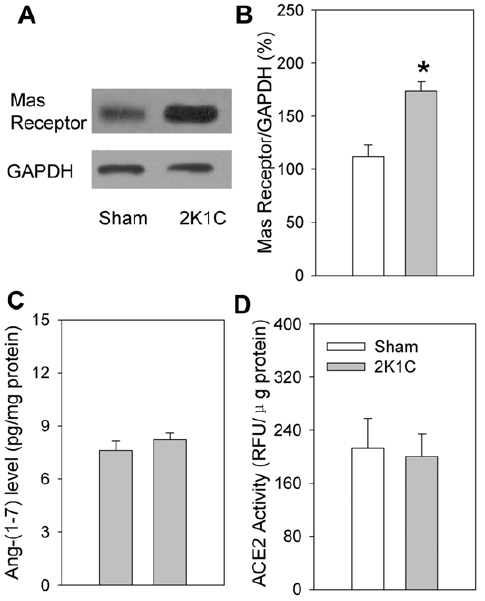
Figure 4. Mas receptor protein expression (A & B), Ang-(1–7) level (C) and ACE2 activity (D) in the PVN in Sham and 2K1C rats. RFU, relative fluorescence units. Values are mean 6 SE. * P , 0.05 compared with Sham rats. n=5 for each